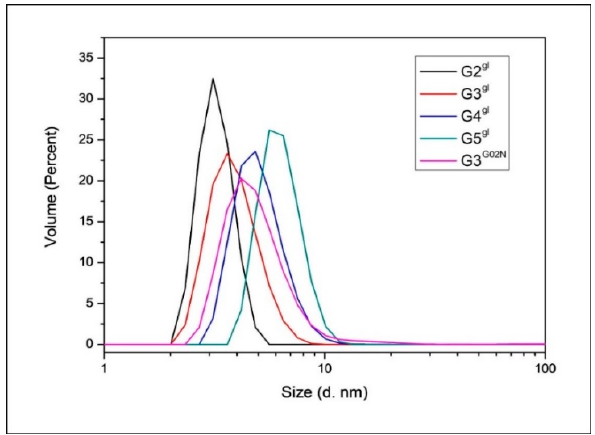
Figure A3. Size distribution of GM gl dendrimers and G3 G02N megamer (M—dendrimer generation). The PAMAM dendrimers coated with 2,3-dihydroxypropyl substituents were synthesized for these studies. The composition of G2 gl –G5 gl was determined using 1 H NMR spectroscopy. The NMR studies on the series will be reported